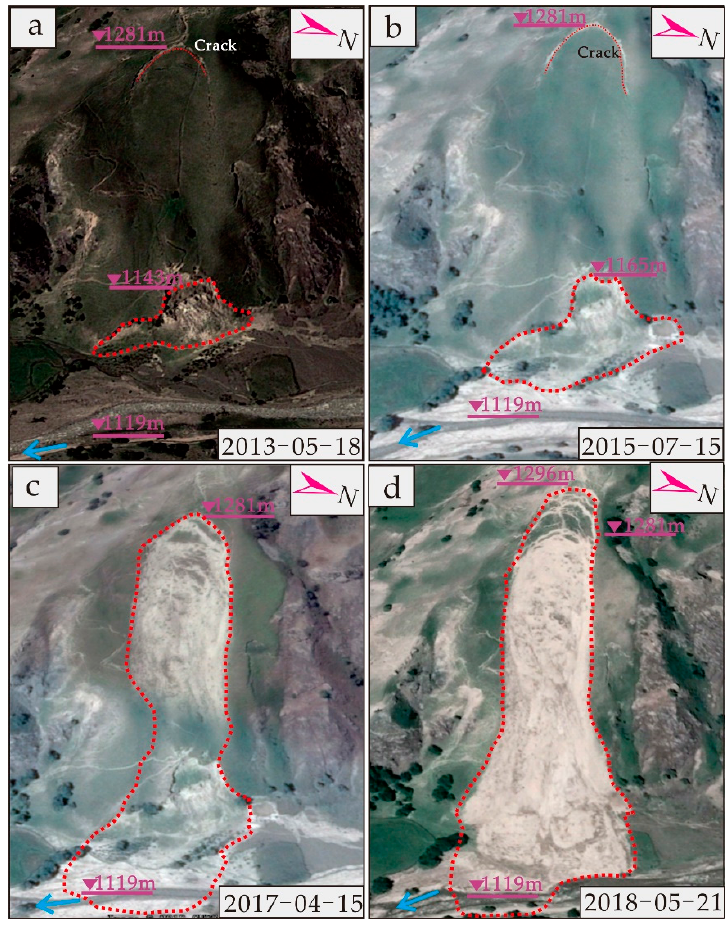
Figure 3. The multi-temporal sensing images of the landslide.